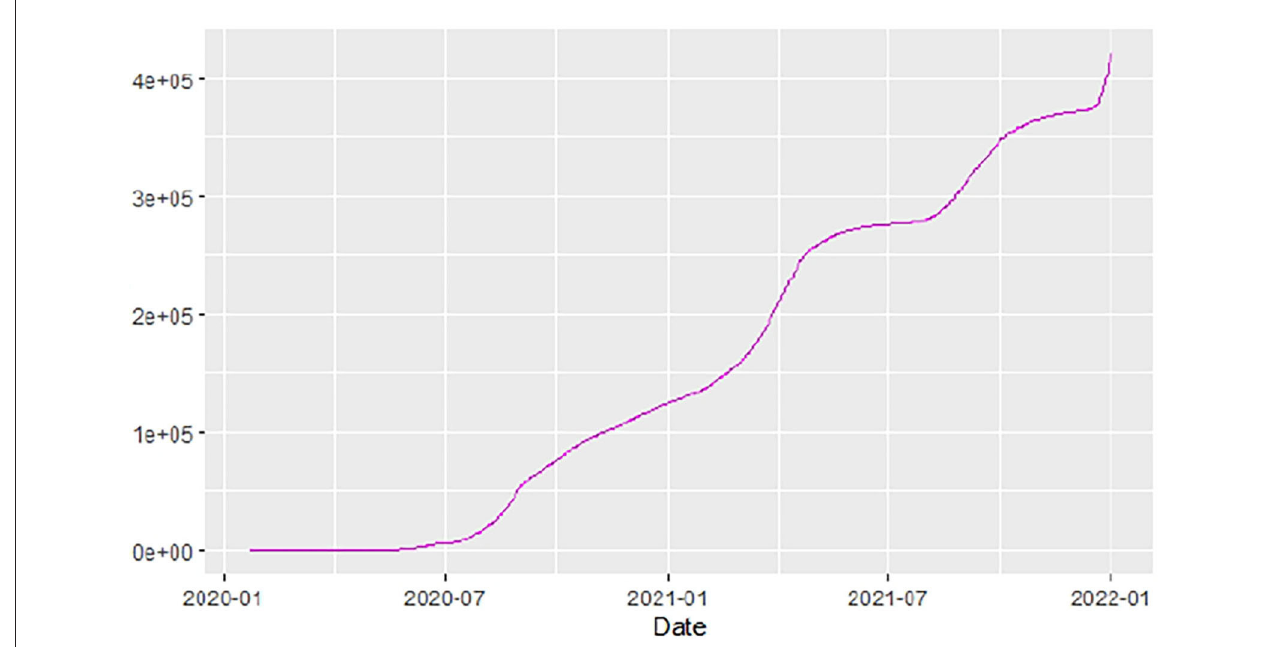
FIGURE 5 | Ethiopia cases.